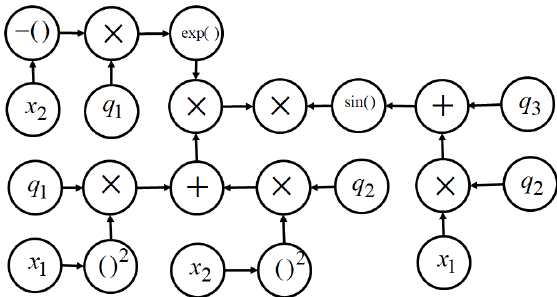
Figure 1. The computational tree for the function (30).